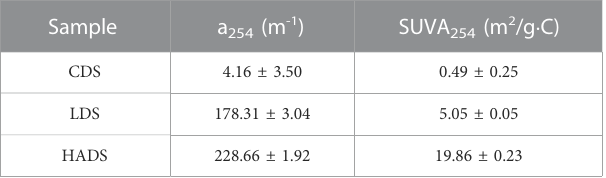
TABLE 2 DOM absorption properties at 254 nm.